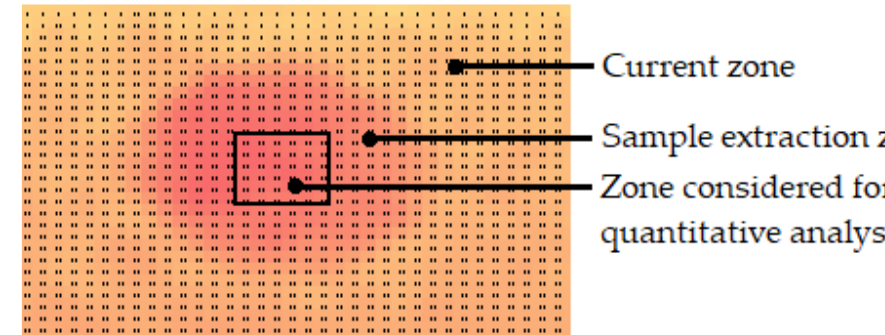
Figure 5. Selected temperatures for the quantitative analysis.